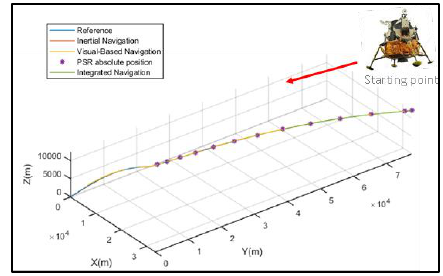
Figure 16. Trajectory result of the integrated